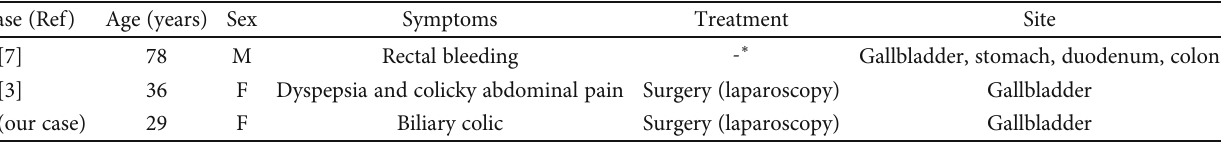
Table 1: Clinical summary of reported cases of angiodysplasia of the